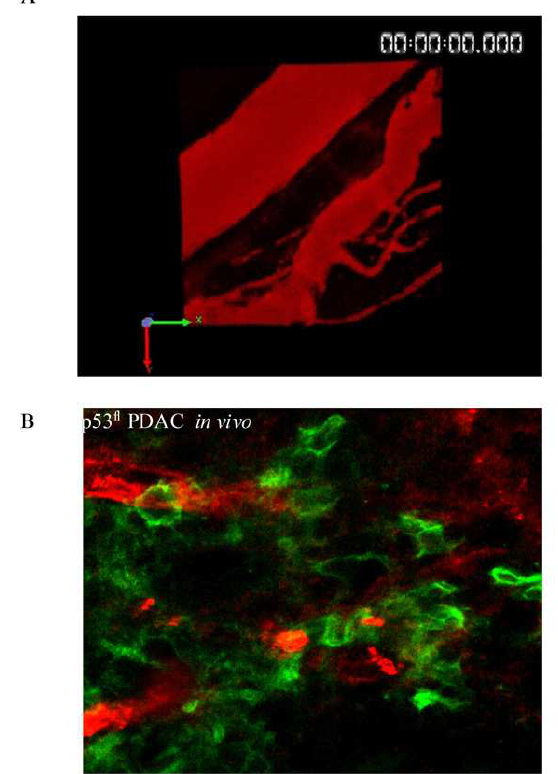
Figure 9. In vivo imaging with Quantum dots. ( A ) 3D rendered image of blood vasculature in vivo labeled by tail vein injection of mouse model with Qtracker 655 quantum dots; ( B ) Contextual imaging of cells in vivo . p53 fl pancreatic ductal adenocarcinoma cells expressing plasma membrane bound GFP (green) within an in vivo tumor in live mouse. Blood vasculature is highlighted in red by tail vein injection of Qtracker 655 quantum